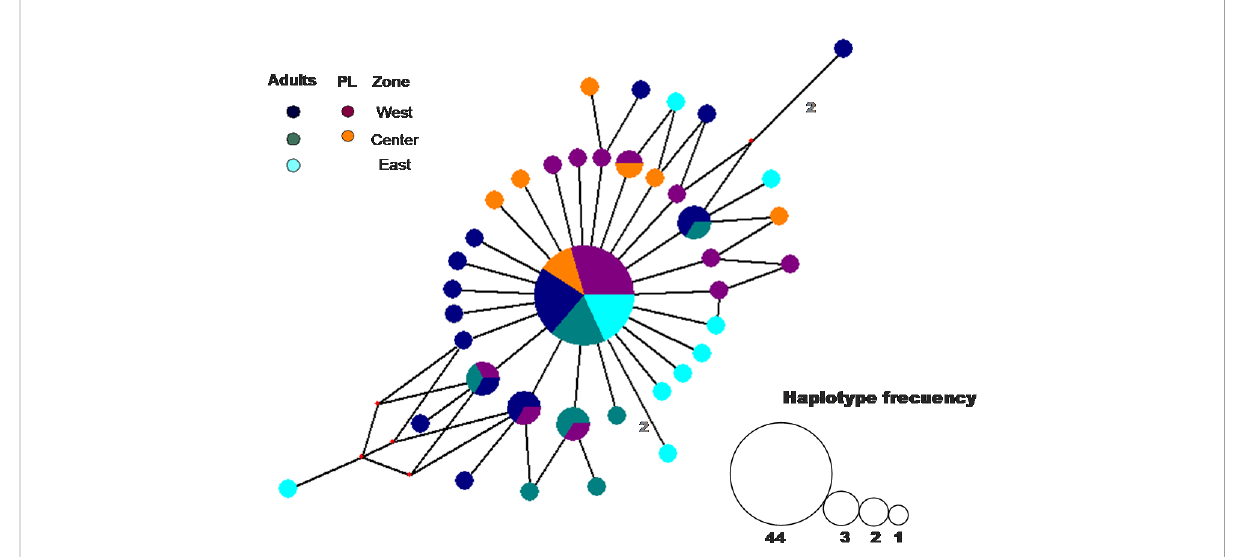
FIGURE 7 D. pleii haplotype network of PL and adult specimens from Southeastern Gulf of Mexico. Circles represent a unique allele. Red dots are the calculated average